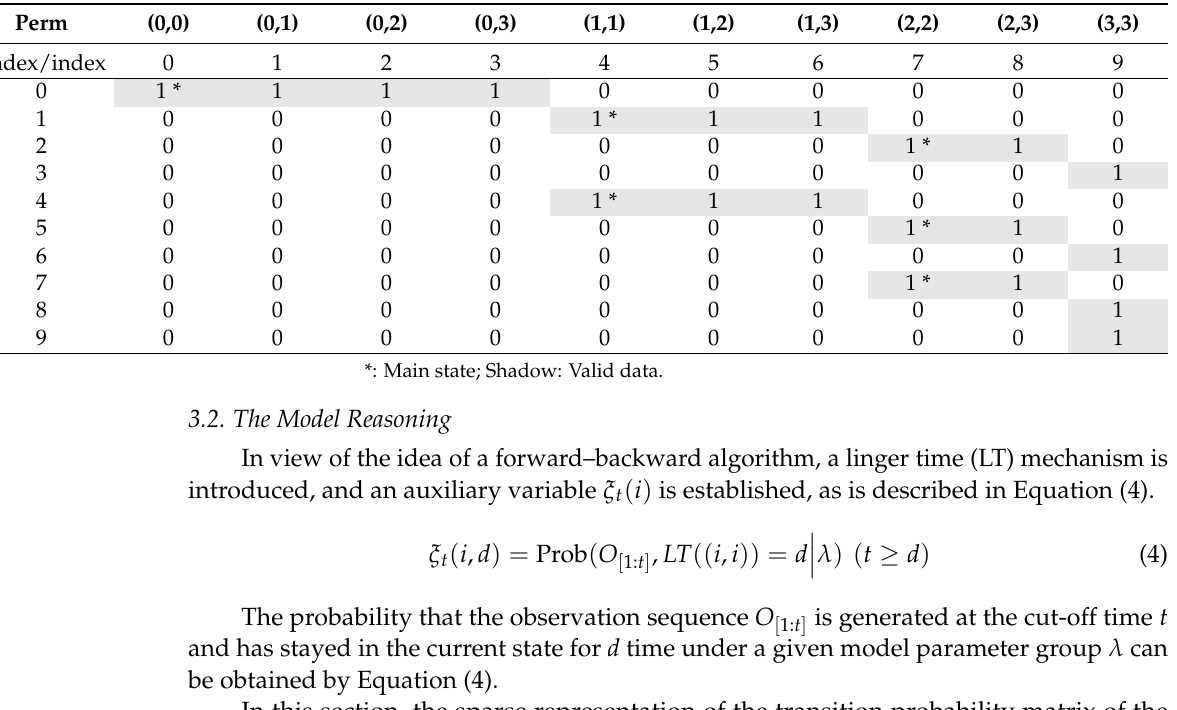
Table 1. Sparse representation of two-order HOHSMM reduced-order transition probability matrix with 4 states.